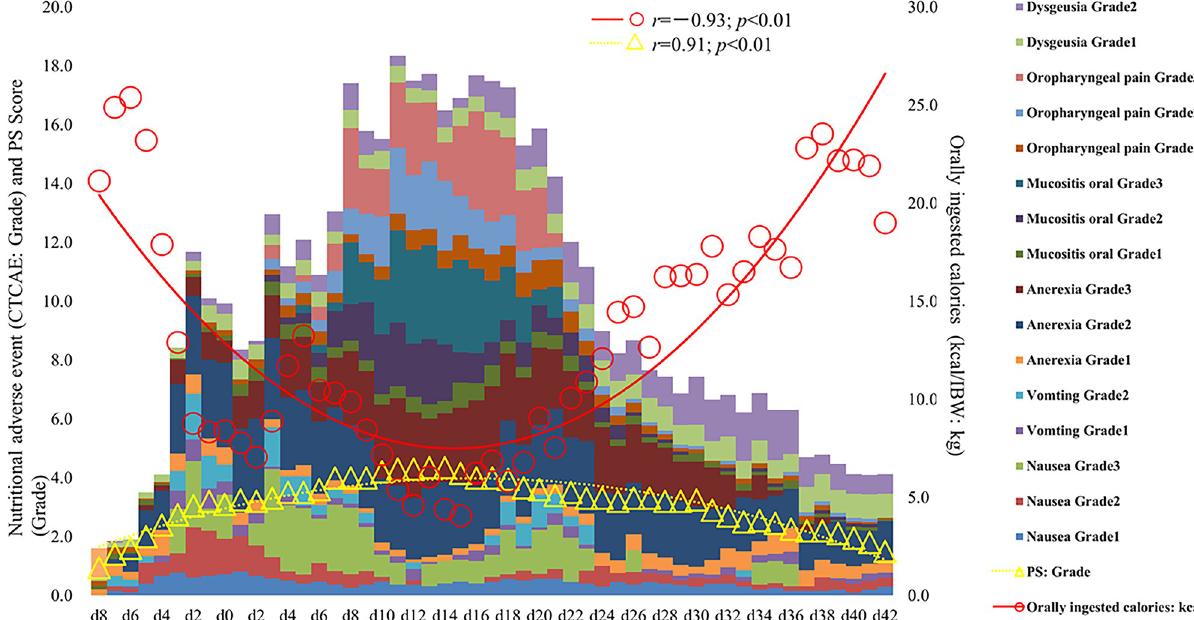
Fig 7. Nutrition-related adverse events and oral caloric intake from T1 to T2 and standard weight and performance status assessments over time.